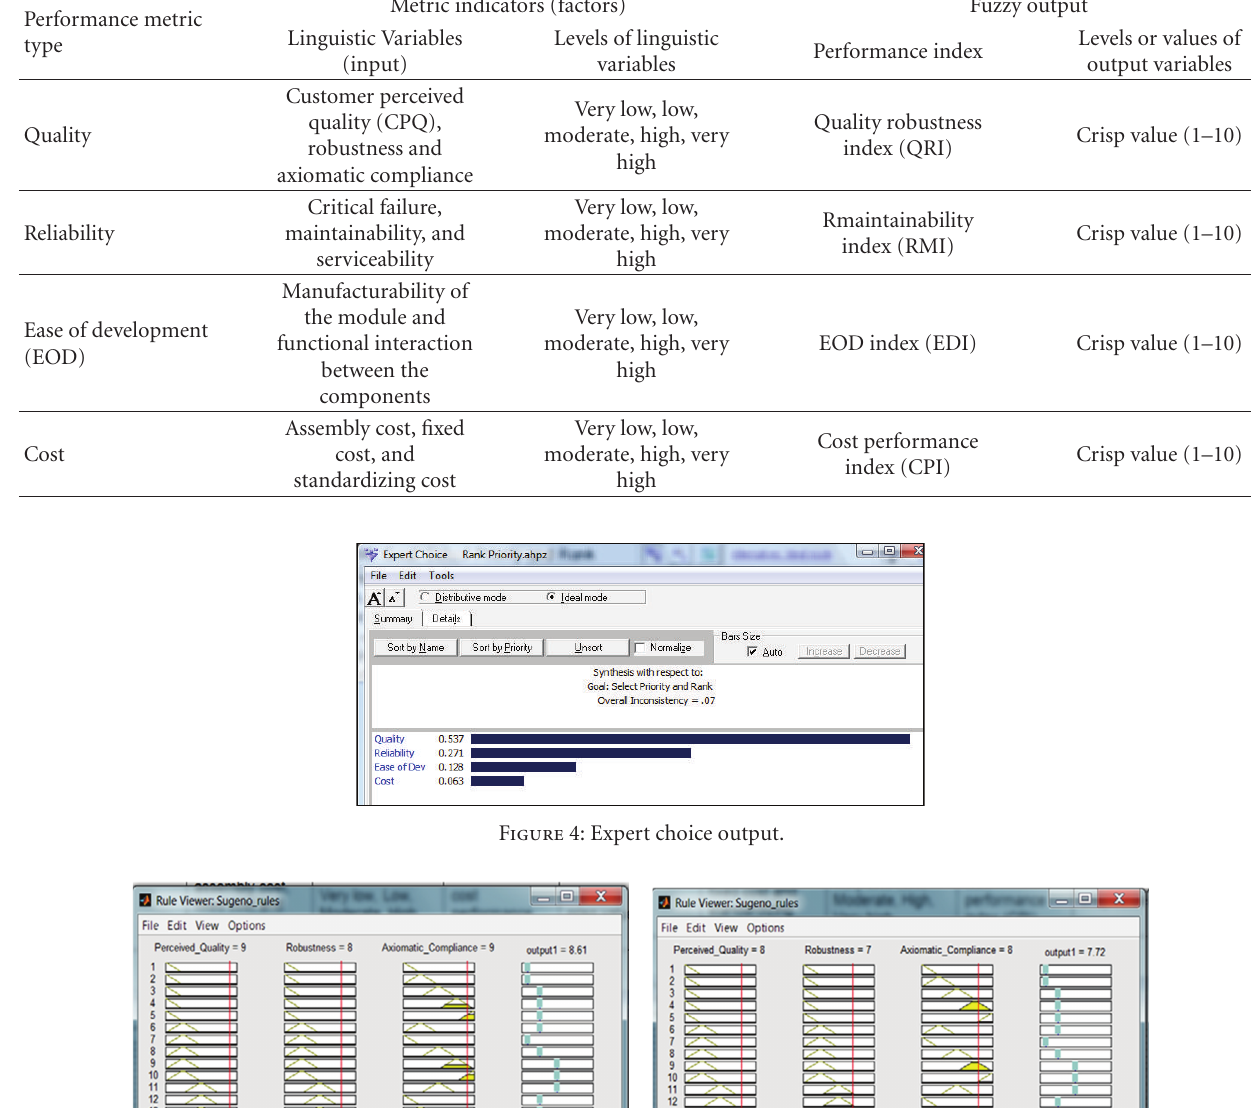
Table 3: Measurement parameters.